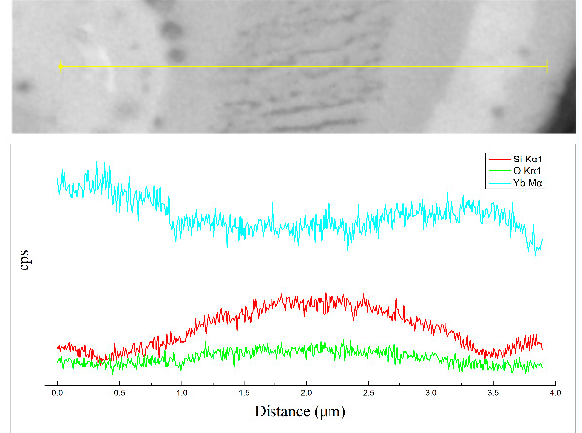
Figure 9. EDS line scan of annealed ytterbium silicate top-coats prepared by parameter set A. The cross-sectional micrographs (back-scattered electron) and EDS analyses of the annealed